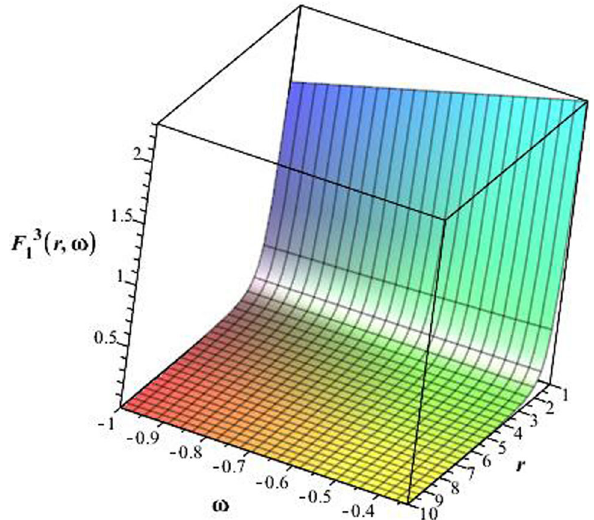
( r ,ω) as a function of ω and Fig. 8 The plot depicts the function F 3 1 ( r ,ω) is positive through the entire range of ω r for. It is clear that F 3 1 and r . This shows that condition ρ + p t ≥ 0 holds everywhere. See the text for